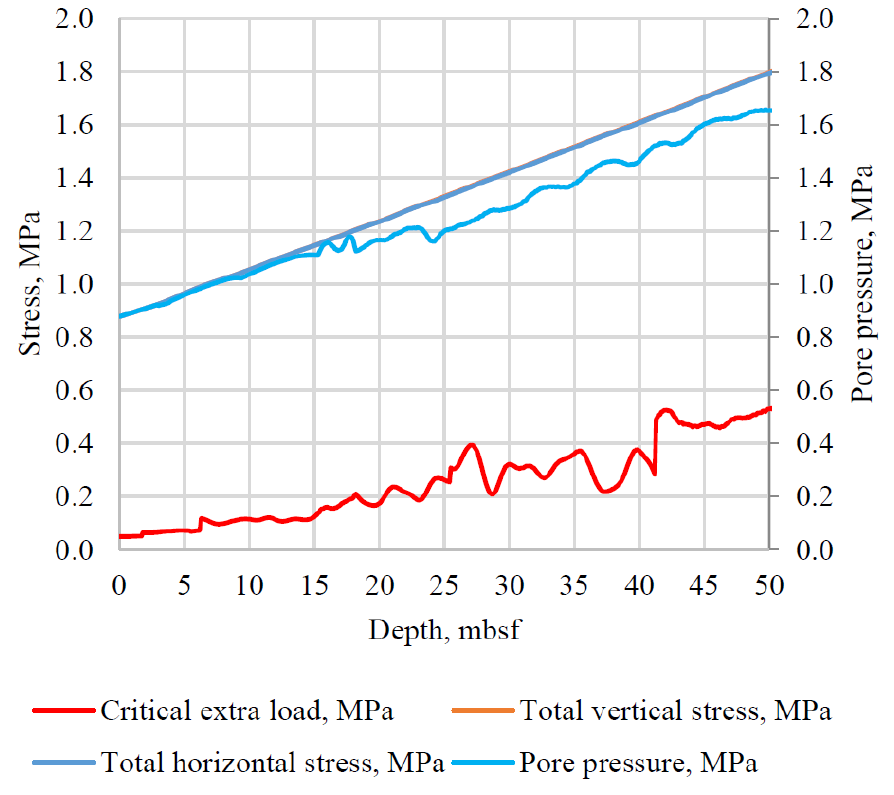
Figure 9. Critical load estimation for rock-physics modeling.